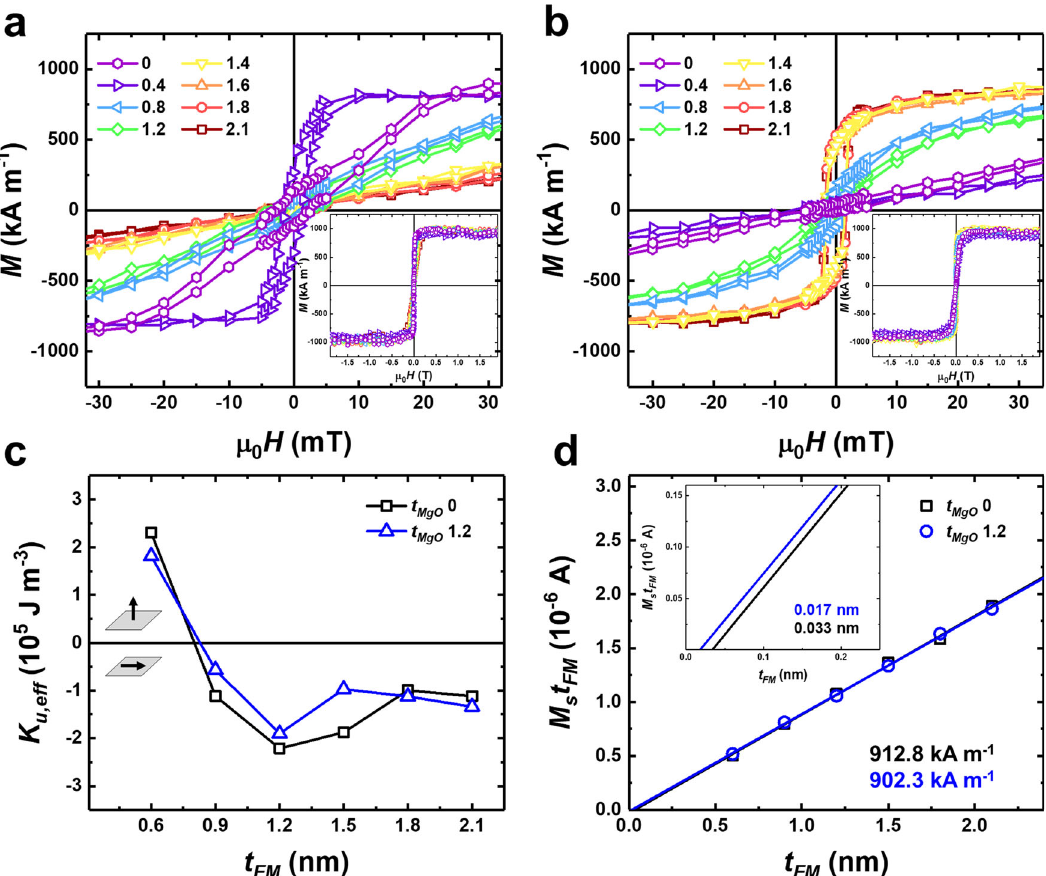
Fig. 1 Magnetic properties of Ta(3)/Pt(5)/MgO( t MgO )/CoFeSiB(0.9)/MgO(1)/Ta(2). a , b The Out-of-plane ( a ), and in-plane ( b ) hysteresis loops for as-deposited samples. The inset shows full out of plane, and in-plane hysteresis loops. c Uniaxial anisotropy energy ( K u,eff ) as a function of CoFeSiB thickness ( t FM ). d Linear dependence of M s t FM = f( t FM ) exhibits effective saturation magnetization ( M s eff ) as a slope and magnetically dead layer as an x -intercept. M s eff of each sample is depicted for each color, and a magnetically dead layer is written within the inset. Each color corresponds to the series of samples indicated in the